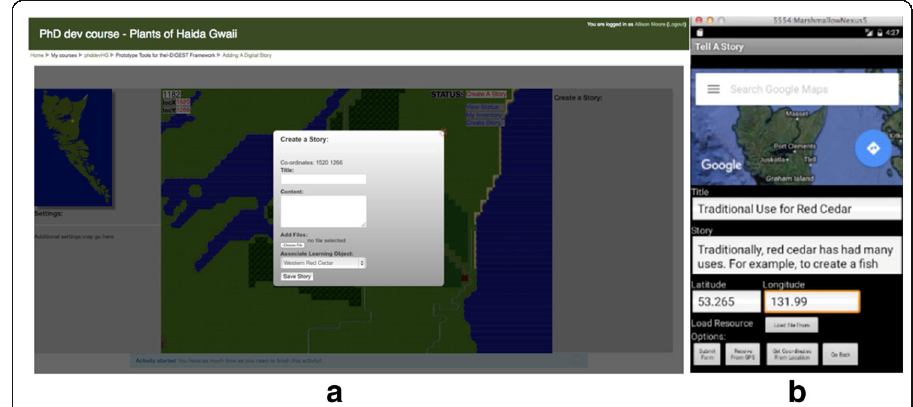
Fig. 5 Methods for adding a digital story to a course using; ( a ) web interface, ( b ) mobile app interface; ICT – Information and communications technology, IK – Indigenous knowledge, IMS-LD – IMS learning